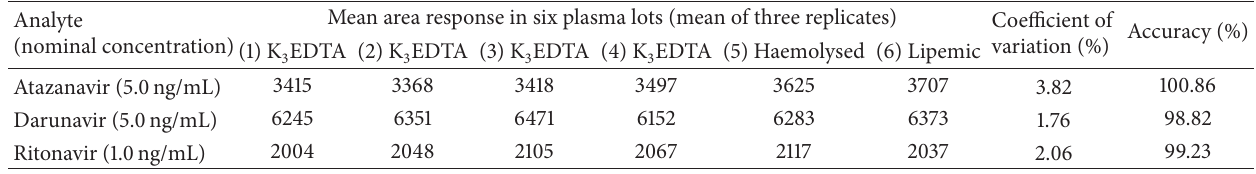
Table 5: Relative matrix effect in different lots of human plasma at LLOQ level.